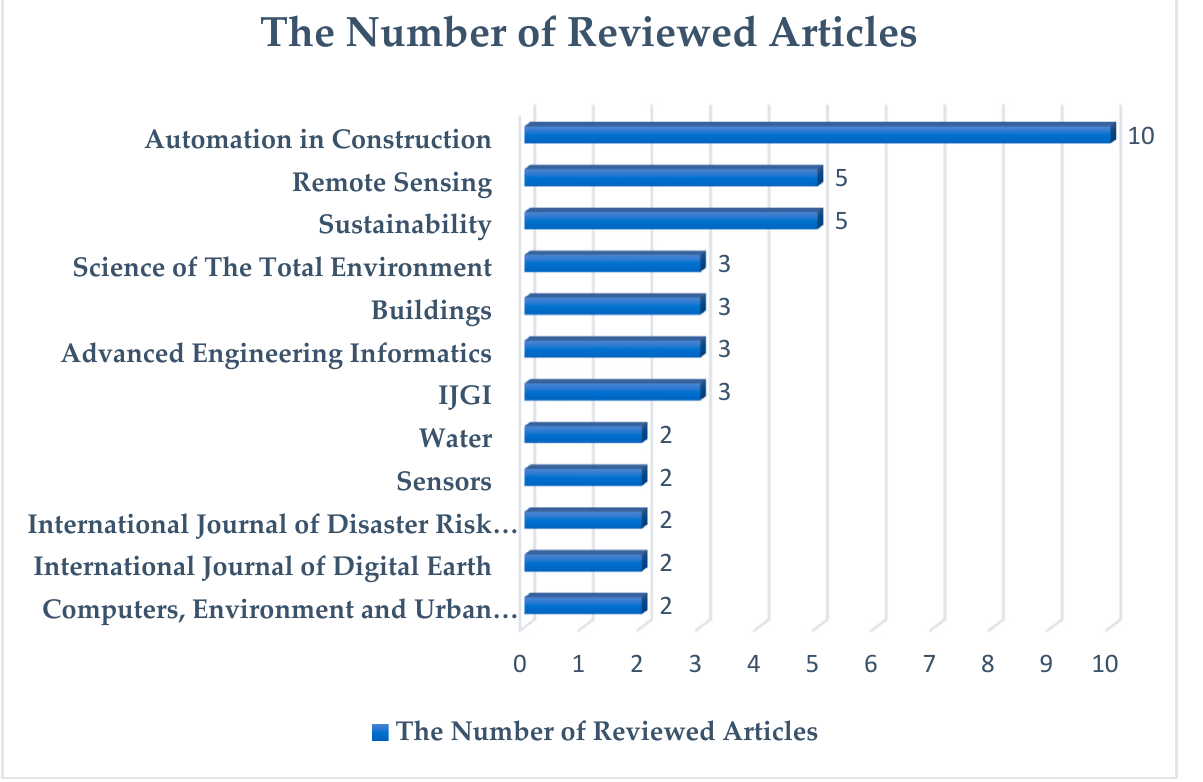
Figure 4. The Number of Reviewed Articles Published Per Source (only the top 12 journals).